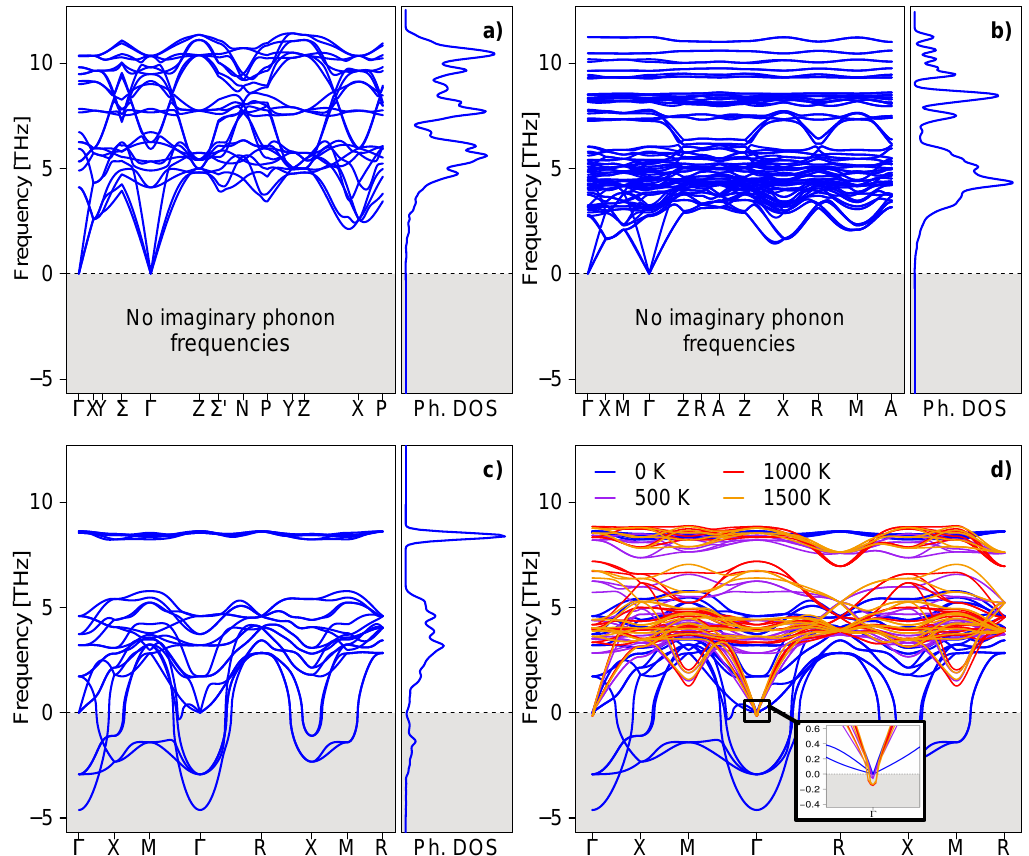
Figure 4. Phonon bandstructure and phonon DOS of the ε -Al 3 Nb ( a ), σ -AlNb 2 ( b ), and δ -AlNb 3 phase ( c ) at 0 K. The paths in the first Brilloiun zone were chosen based on the crystal symmetry considerations, as proposed by Setyawan and Curtarolo [34]. ( d ) Phonon bandstructure of δ -AlNb 3 at elevated